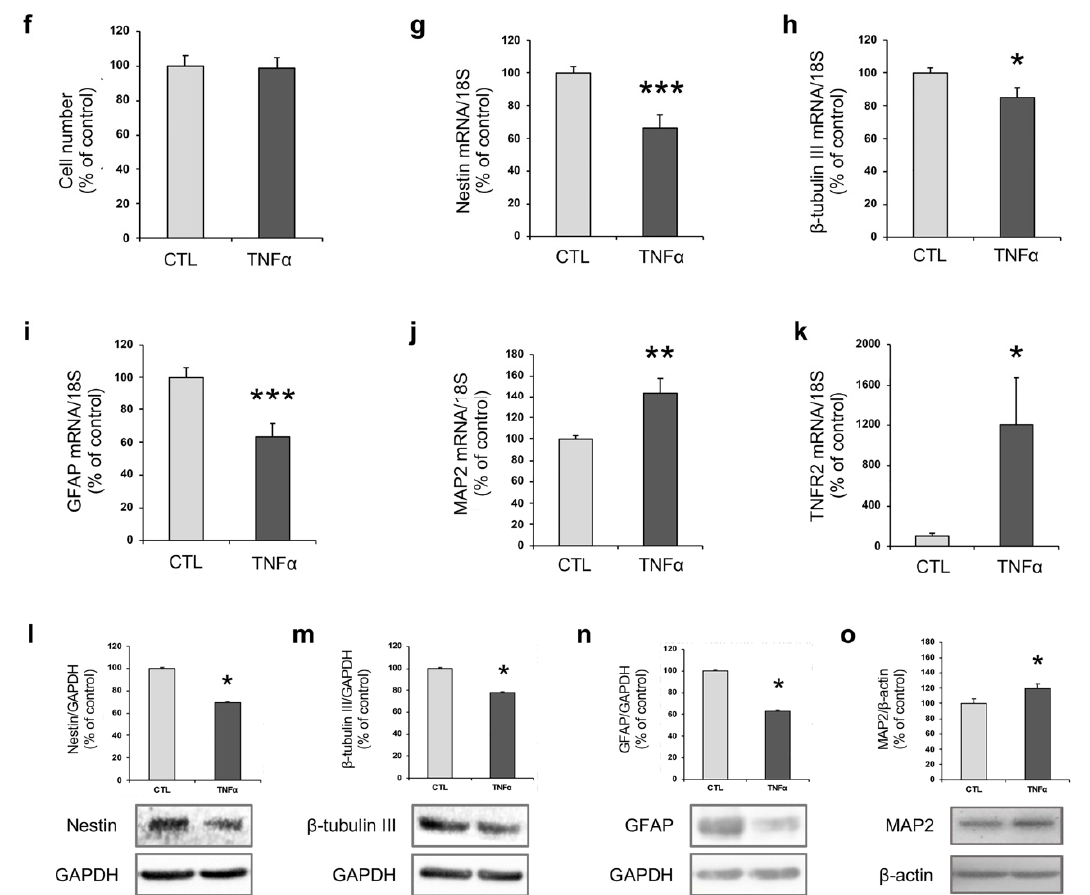
Figure 1. TNF α affects hfNBM cell phenotype. ( a , b ) Representative images showing ( a ) ChAT and ( b ) VAchT expression in hfNBMs as evaluated by immunofluorescence analysis (DAPI counterstained nuclei, scale bar 100 µ m). ( c ) Relative mRNA expression by qRT-PCR analysis of TNFR1 and TNFR2 receptors normalized over 18S ribosomal subunit, taken as reference gene, and reported as mean ± SEM ( n = 6). ( d ) Immunofluorescent analysis of NF- κ B p65 nuclear translocation after TNF α stimulus (10 ng / mL, 3 h) in comparison to untreated cells (CTL; scale bar 100 µ m). ( e ) COX2 mRNA expression in hfNBMs by qRT-PCR after TNF α stimulation (10 ng / mL, 24 h). Data are normalized over 18S ribosomal RNA subunit and reported as percentage of untreated cells (CTL) and displayed as mean ± SEM of three separate experiments performed in triplicate (unpaired Student’s t -test; *** p < 0.001 vs. CTL; n = 9). ( f ) MTT analysis of hfNBMs treated or not (CTL) with TNF α (10 ng / mL, 24 h; n = 3). ( g ) nestin, ( h ) β -tubulin III, ( i ) GFAP, ( j ) MAP2 and ( k ) TNFR2 mRNA expression in untreated (CTL) and TNF α -treated (10 ng / mL, 24 h) hfNBMs by qRT-PCR. Data are normalized over 18S ribosomal RNA subunit and reported as percentage of CTL and displayed as mean ± S EM of four separate experiments performed in triplicate (unpaired Student’s t -test; *** p < 0.001, ** p < 0.01, * p < 0.05 vs. CTL; n = 12 or n = 6). ( l ) nestin, ( m ) β -tubulin III, ( n ) GFAP and ( o ) MAP2 protein expression in untreated (CTL) and TNF α -treated (10 ng / mL, 24 h) hfNBMs by Western blot analysis. Band intensity of the specific protein was normalized over GAPDH or β -actin signal, expressed as percentage of CTL and displayed as mean ± SEM of three separate experiments (unpaired Student’s t -test; * p < 0.05 vs. CTL; n =